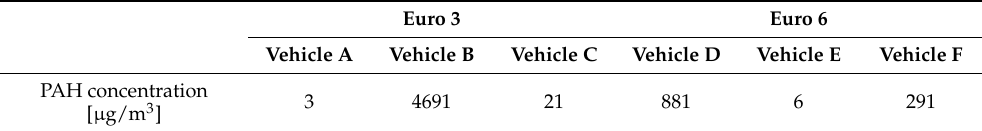
Table 3. PAH concentration in the tested vehicles.